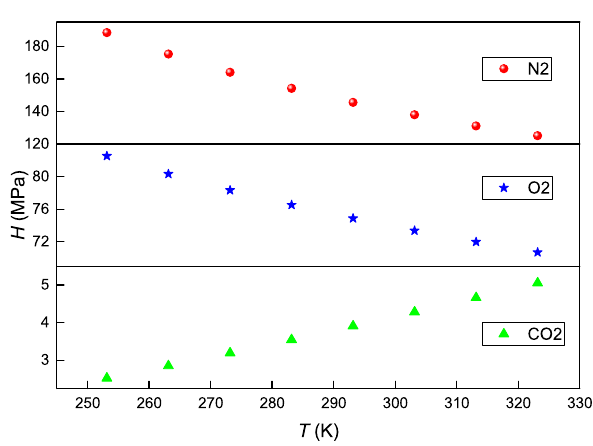
Figure 9. Henry’s constant versus temperature for CO 2 , O 2 and N 2 in